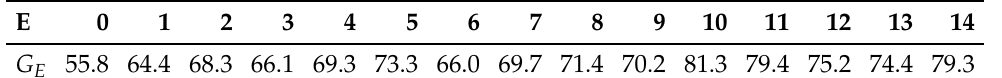
Table 5. Input table–Extraversion level Grade against Extraversion level.